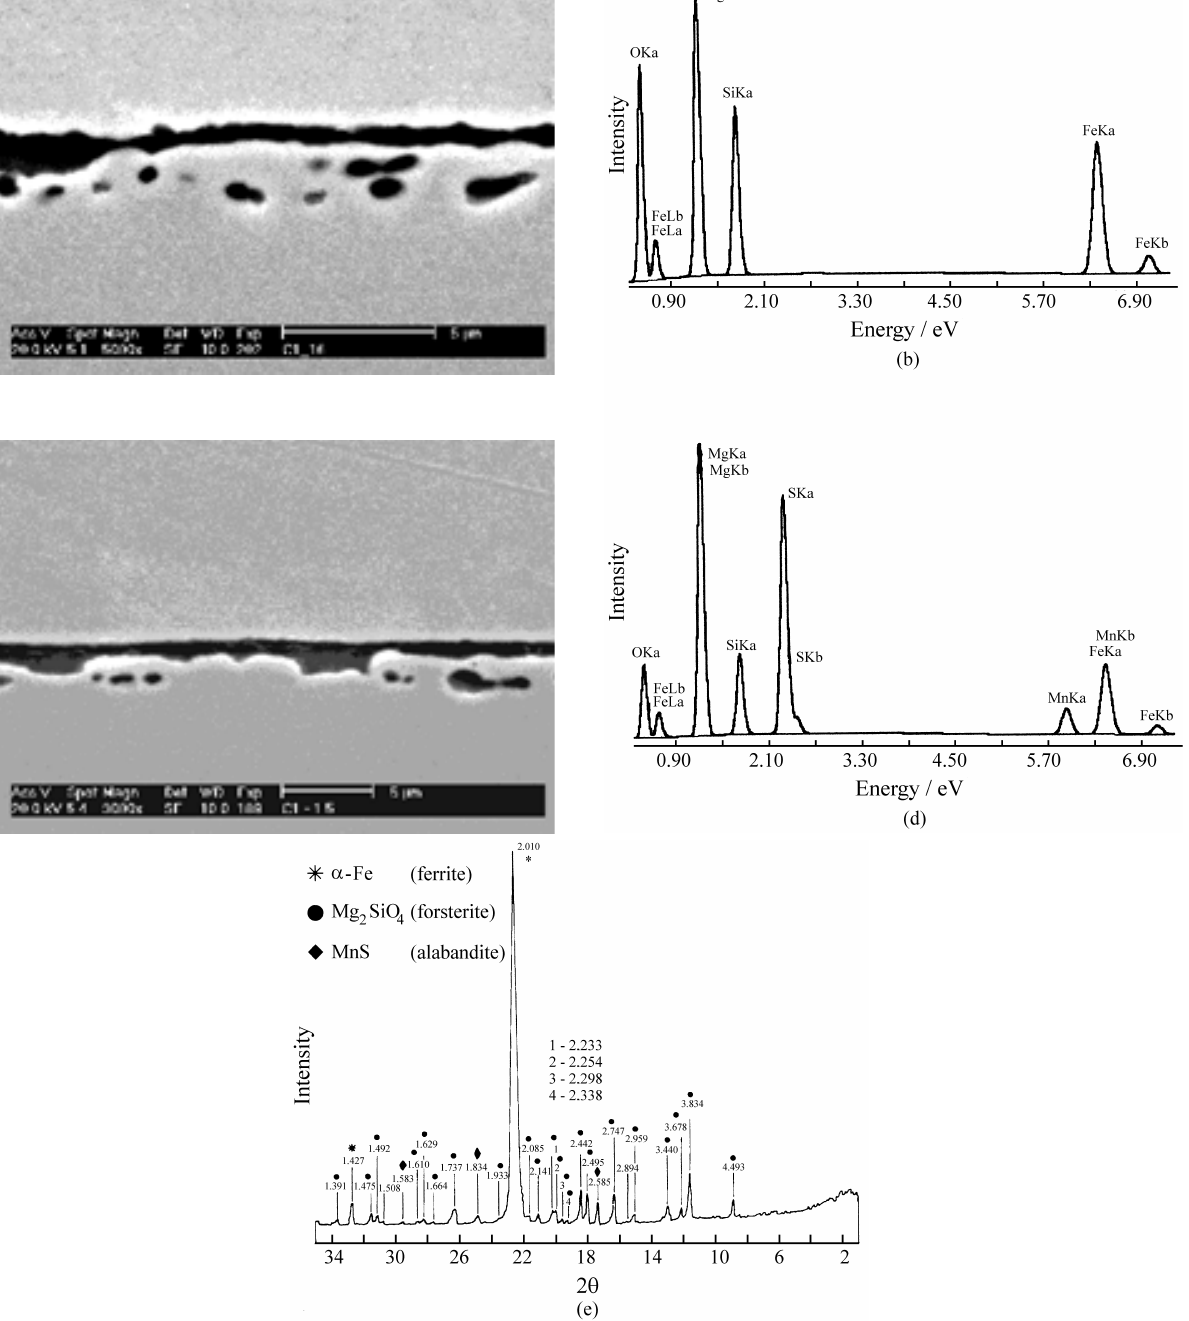
Figure 2. Typical oxide layer formed with the MgO slurry deposition. (a) 5000X. (b) EDS spectrum obtained for the continuous layer and for the dark particles of Fig. 2a; (c) 3000 X; (d) EDS spectrum for point 1; (e) X-ray diffraction spectrum of the ceramic